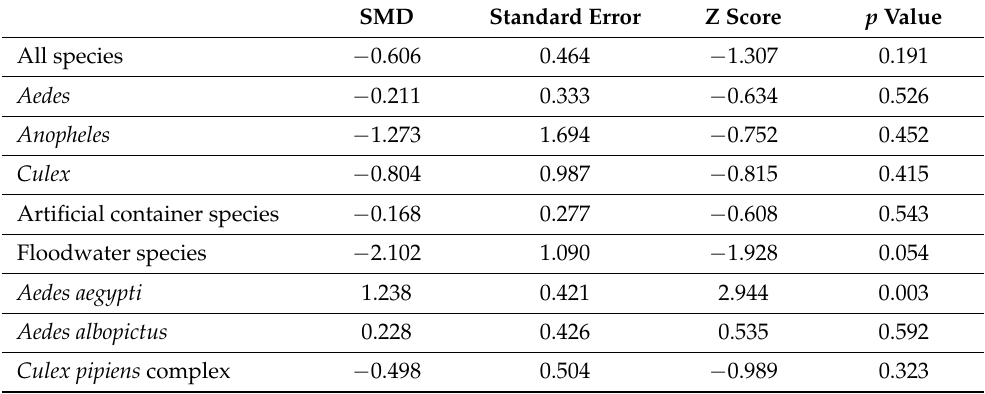
Table 2. Standardized mean difference (SMD) of each group examined.